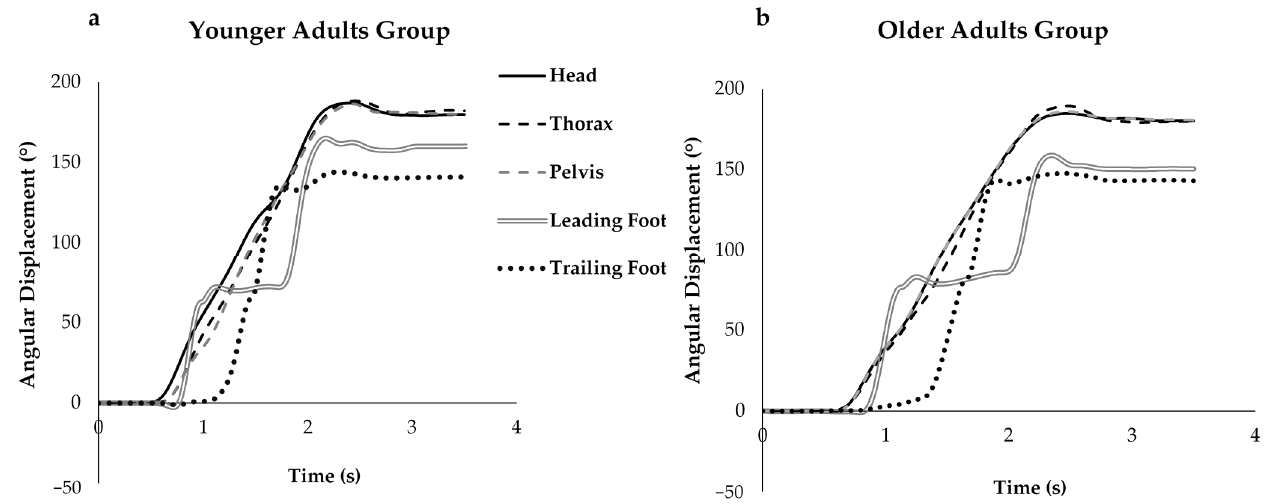
Figure 3. Turn displacement raw data from one trial of moderate speed in ( a ) younger adults group and ( b ) older adults group. This shows that segment reorientation began with the rotation of the head, followed by the trunk, pelvis, and the leading and trailing foot, which was seen in both groups.